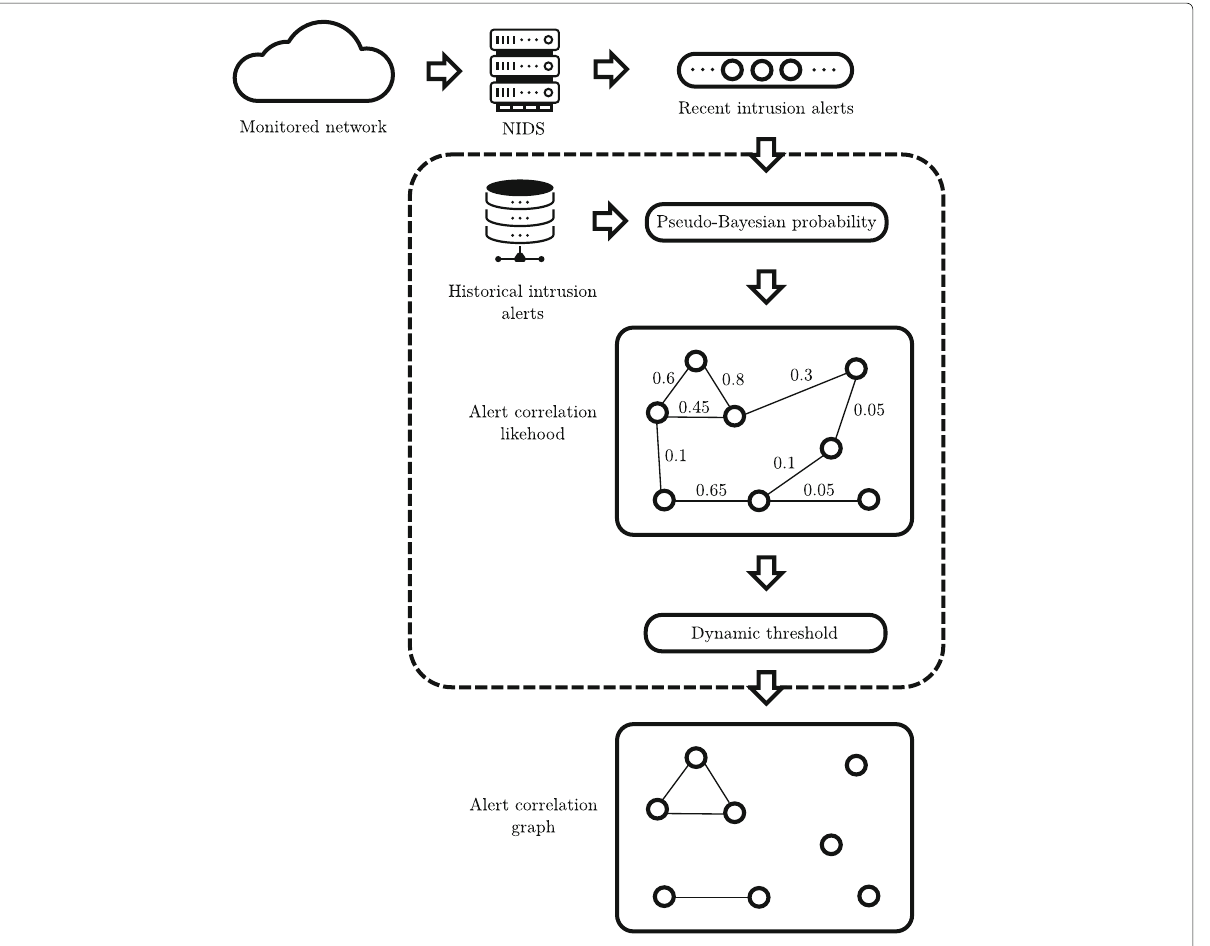
Fig. 7 High -level architecture for pseudo-Bayesian alert correlation